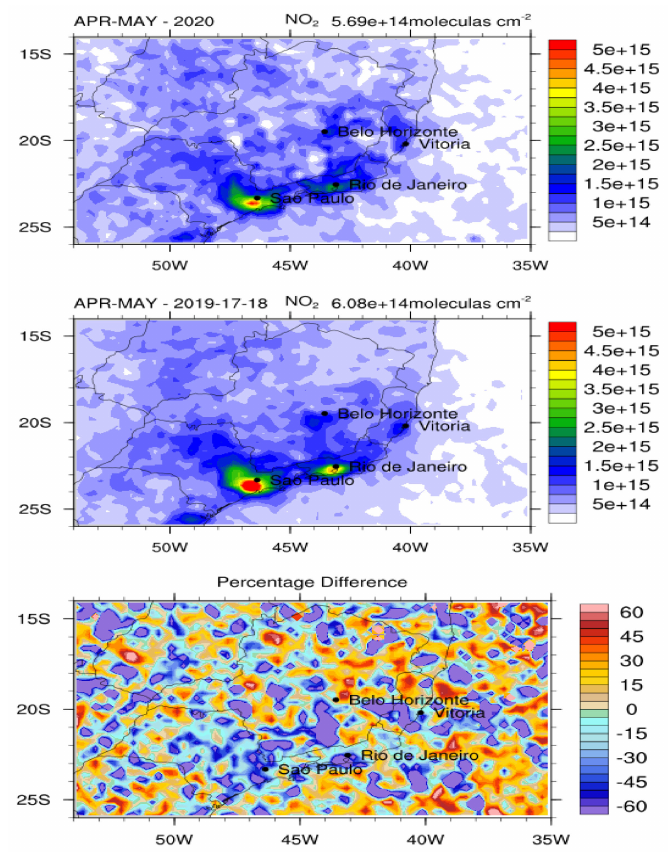
Figure 3. NO 2 atmospheric concentration near the surface for the period of April and May during the pandemic (2020) and pre-pandemic (2017–2019) periods from the OMI sensor, and the percentage differences between the pandemic and pre-pandemic